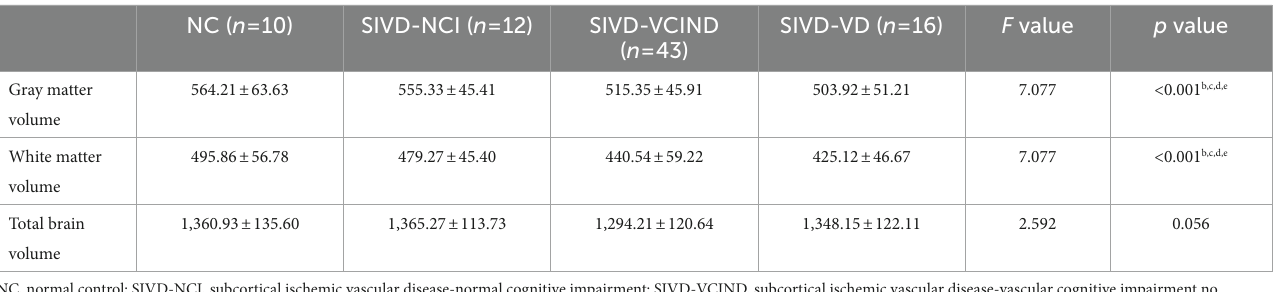
TABLE 3 Structural magnetic resonance characteristics of